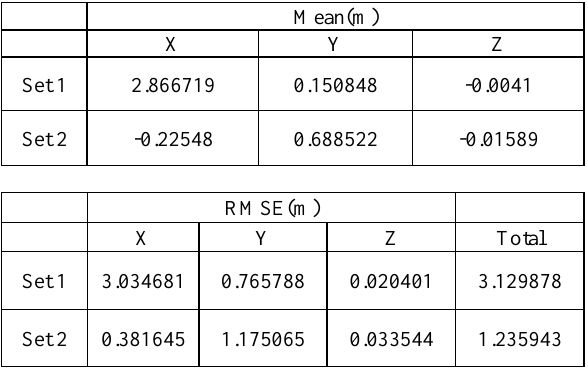
Table 5. Mean & RMSE using single Photo